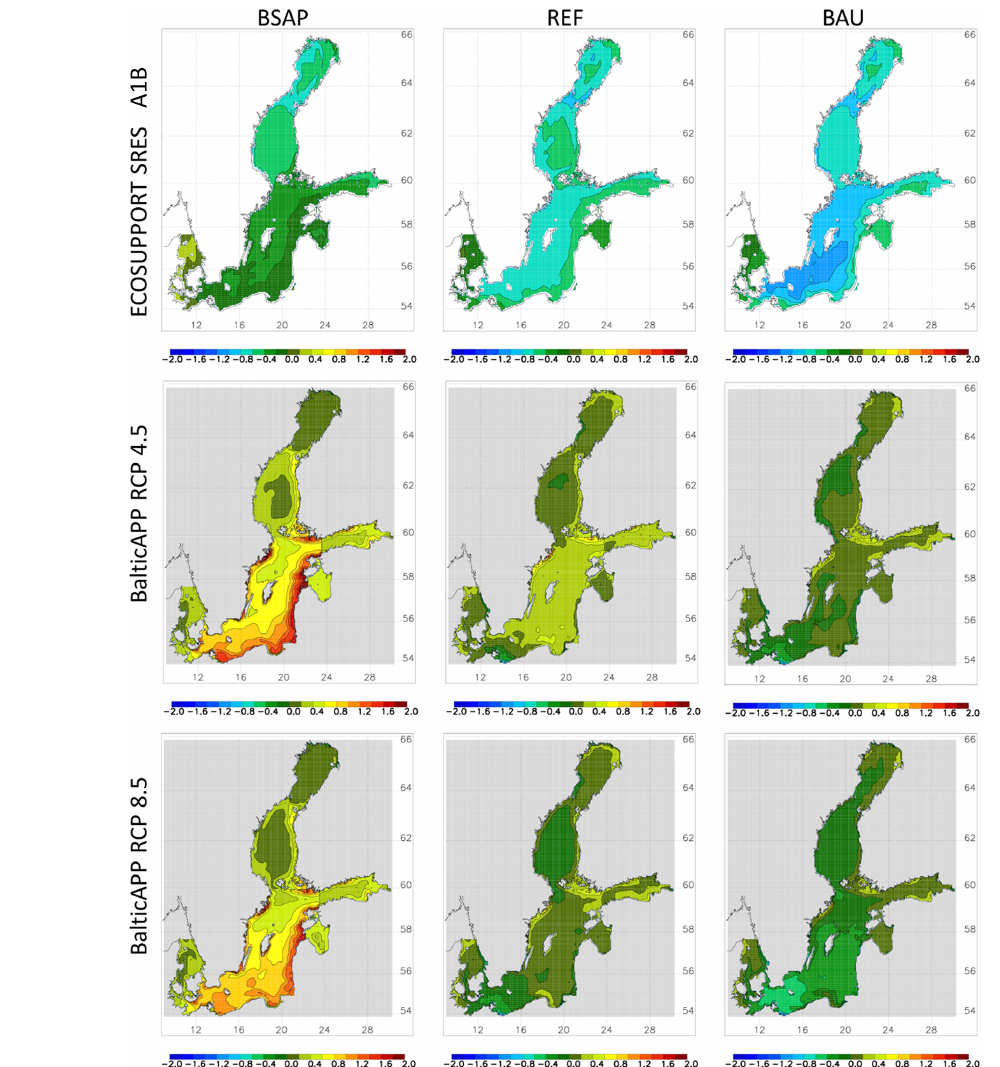
Figure 25. As in Fig. 21 but for changes in the annual mean Secchi depth (m). (Source: Meier et al., 2011b; Saraiva et al.,